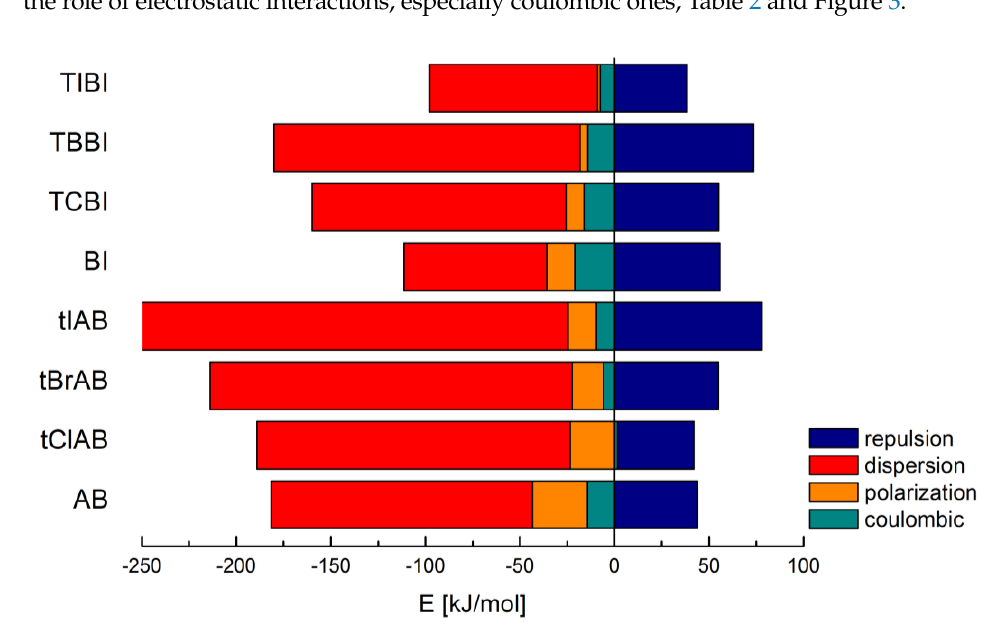
Table 4. Separation of coulombic/polarization/dispersion/repulsion terms to the total lattice calcu- lated within Spackman scaled approach.